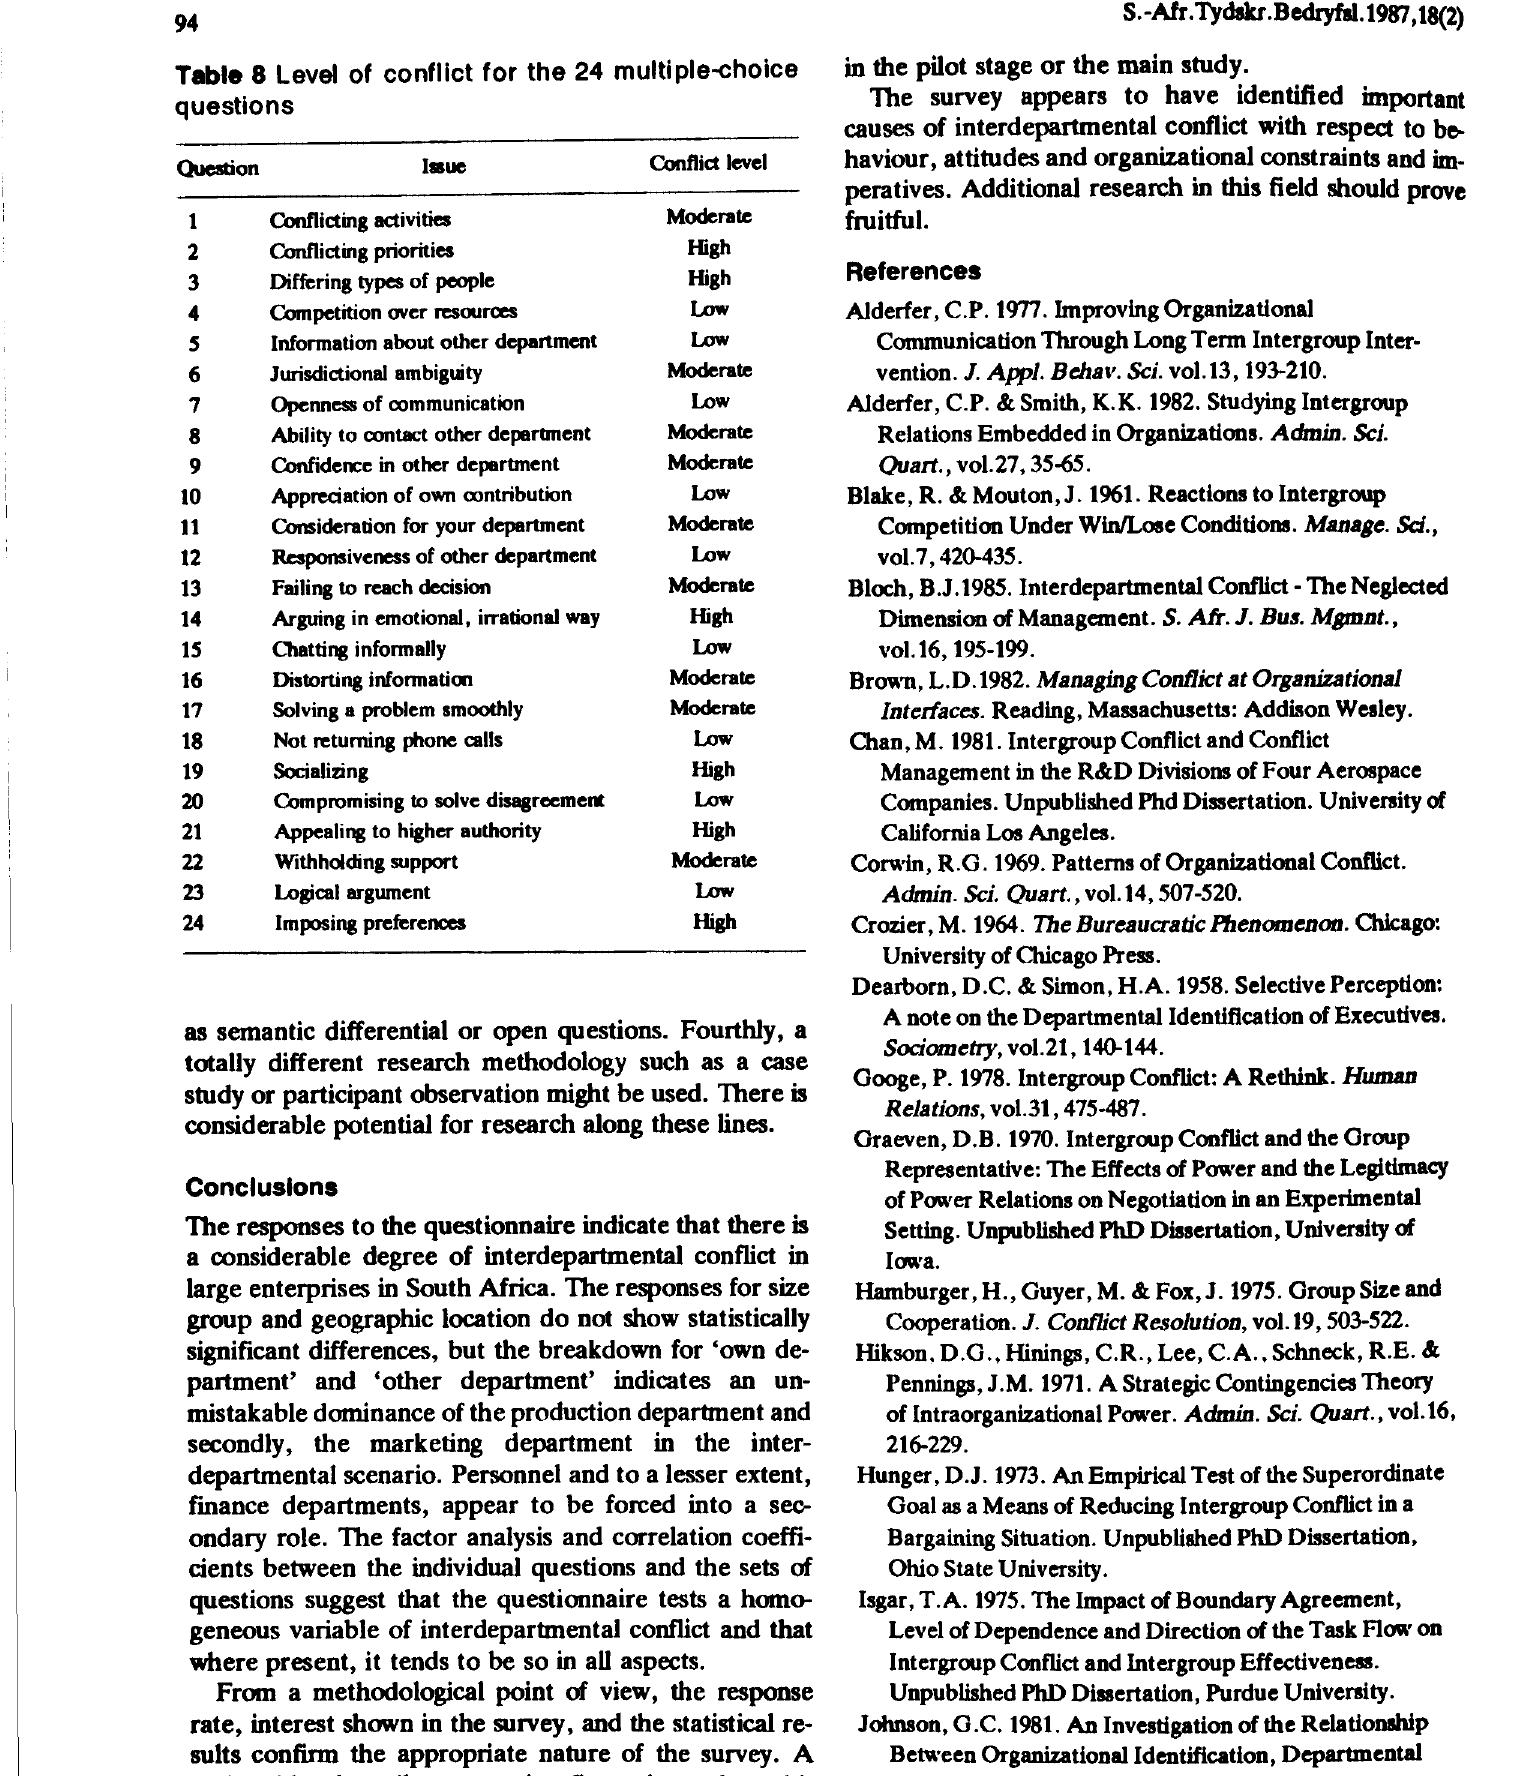
Table 8 Level of conflict for the 24 multiple-choice